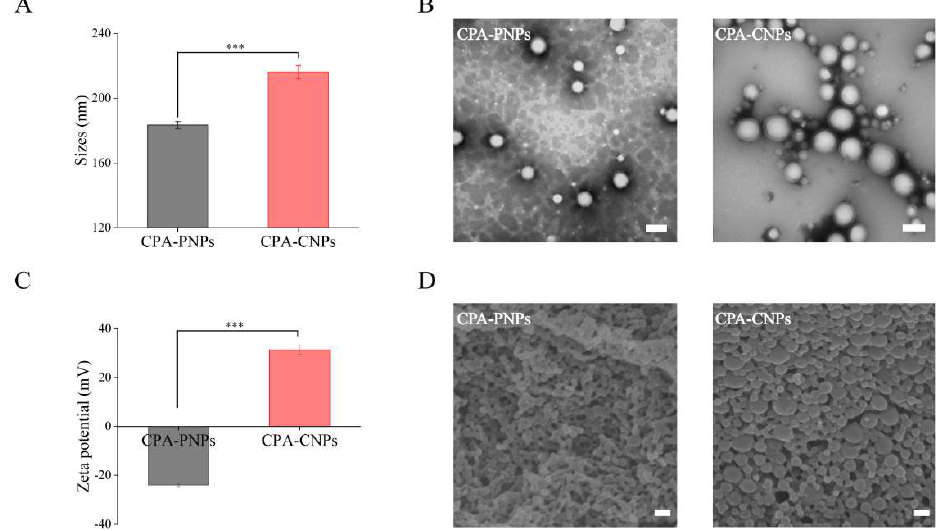
Figure 2. Characterization of nanoparticles. ( A ) The size and ( C ) zeta potential of CPA-PNPs and CPA-CNPs. ( B ) TEM and ( D ) SEM images of CPA-PNPs and CPA-CNPs (scale bar = 100 nm). ( n = 3, mean ± SD, *** p < 0.001).